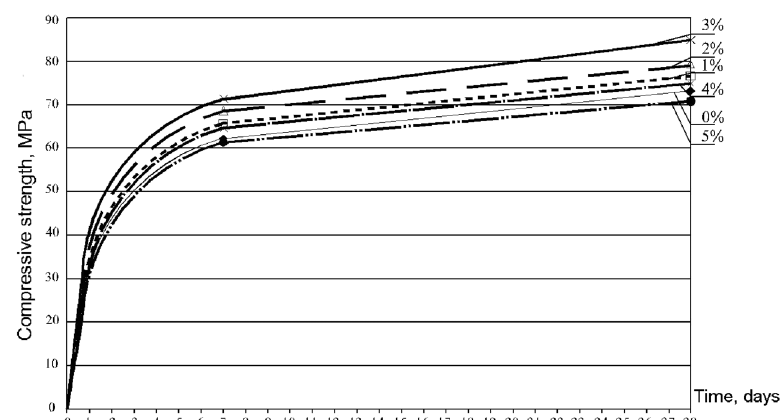
Figure 7: Kinetics of strength of fi ber - reinforced cement stone.